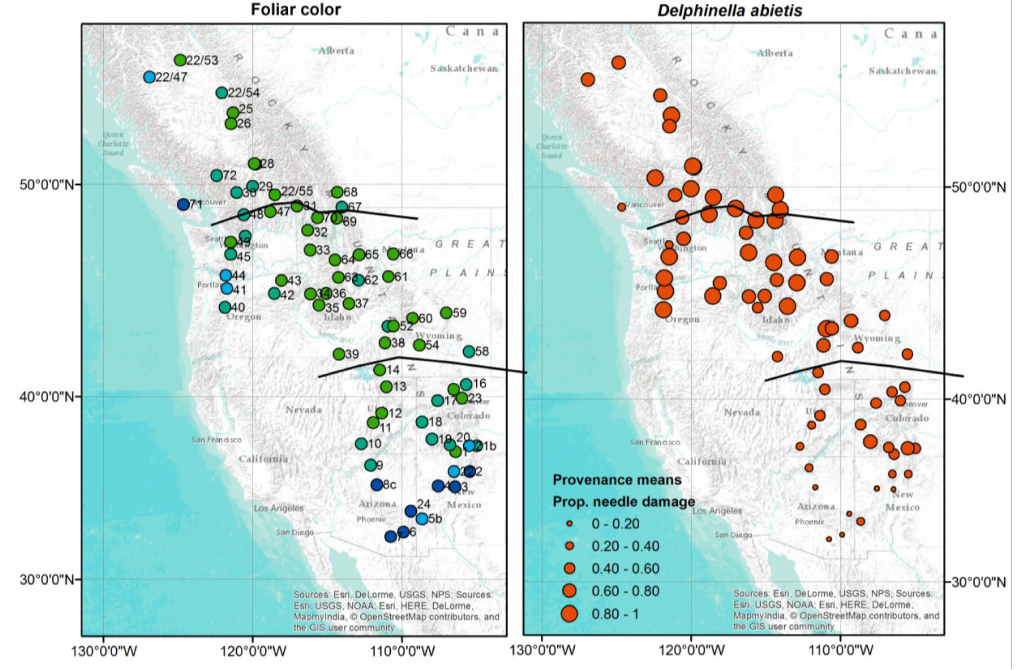
Figure 8. The 76 provenances of subalpine fir ( Abies lasiocarpa ) at Jønsberg projected on a map covering their origin in Canada and USA. Colored dots on the left map indicate the gradient of foliar color on each provenance (from blue to green). In addition, provenance numbers are given next to the dots (see Table A1 for further information about the provenances). Red dots on the map to the right show the level of infection by Delphinella abietis on each provenance at Jønsberg in 2013. The three regions (Northern-, Medium- and Southern latitude) are divided by two black